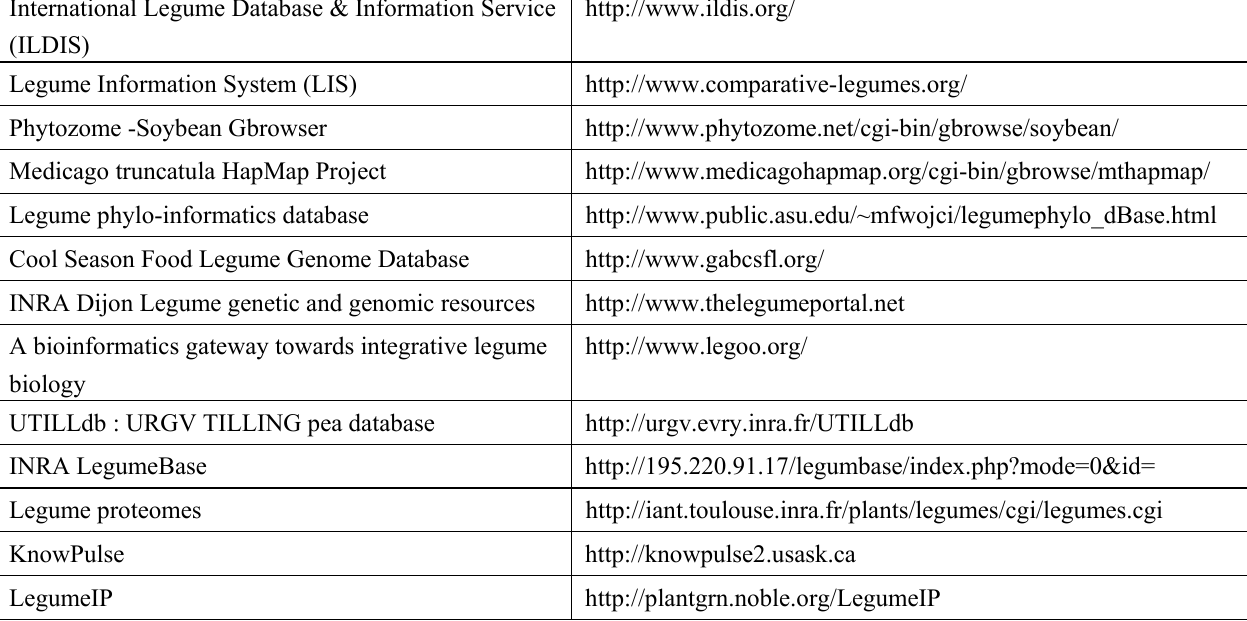
Table 3. List of web databases providing links to pea related